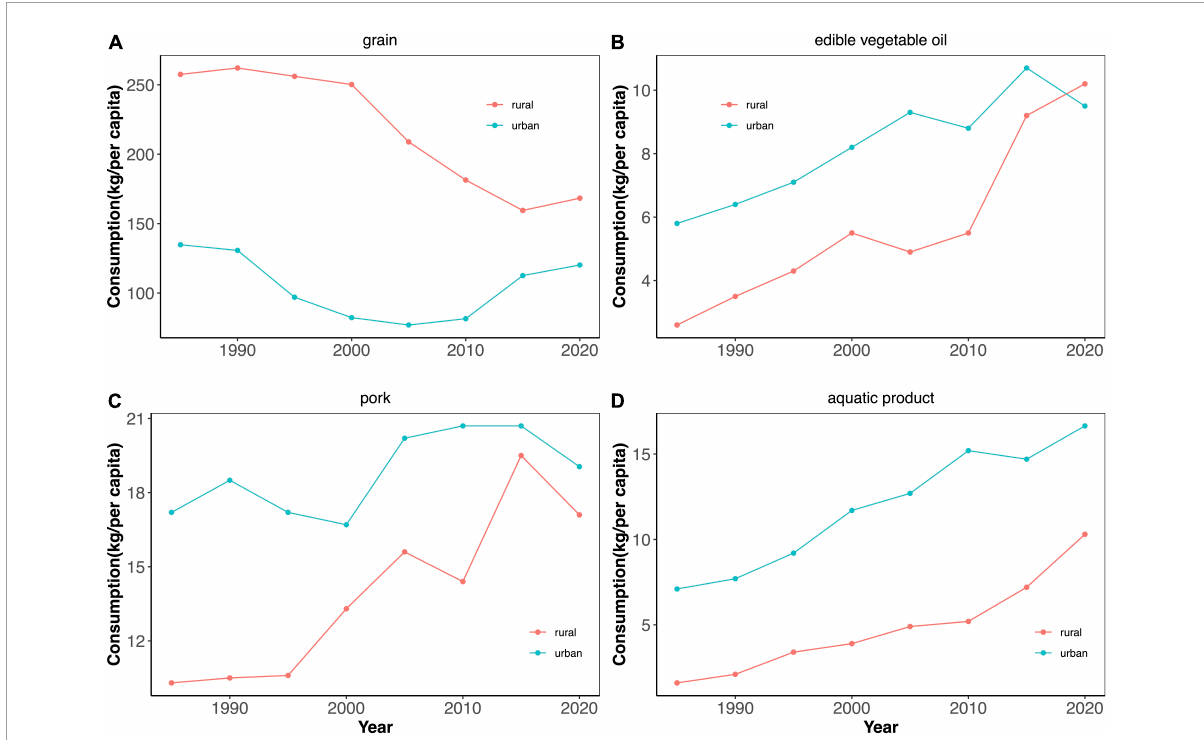
FIGURE1 Urban-rural trends of per capita consumption of four main foods from 1985 to 2020. The data has been aggregated to the urban and rural average level from the micro household level by the National Bureau of Statistics. The occasion of observation is equal to 36 (More specifically, 36 for the average food consumption of rural residents from 1985 to 2020, and 36 for the average food consumption of urban residents in each year from 1985 to 2020). The red and blue lines denote per capita consumption of grain, edible vegetable oil, pork, and aquatic product of rural and urban residents, respectively.